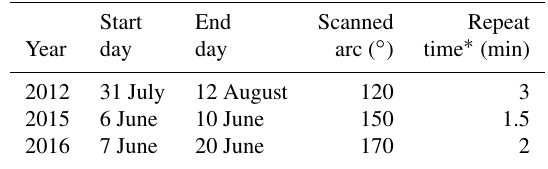
Table 1. TRI observation